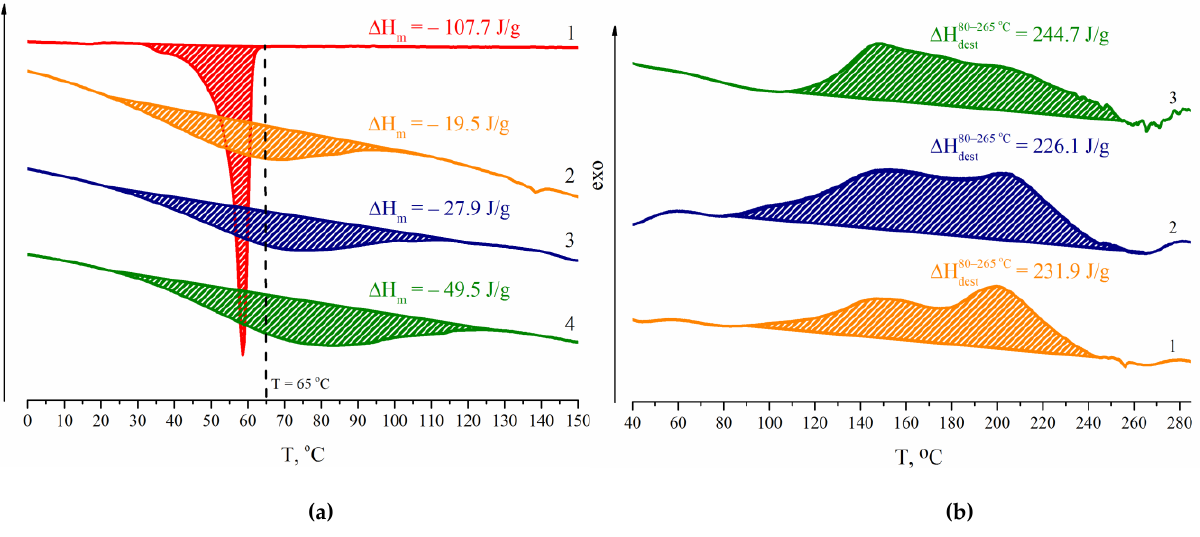
Figure 8. DSC thermograms for WPU films: ( a ) 1—PCL, 2—sample 2.1; 3—sample 2.4; 4—sample 2.7; ( b ) 1—sample 1.1; 2—sample 1.4; 3—sample 1.7.